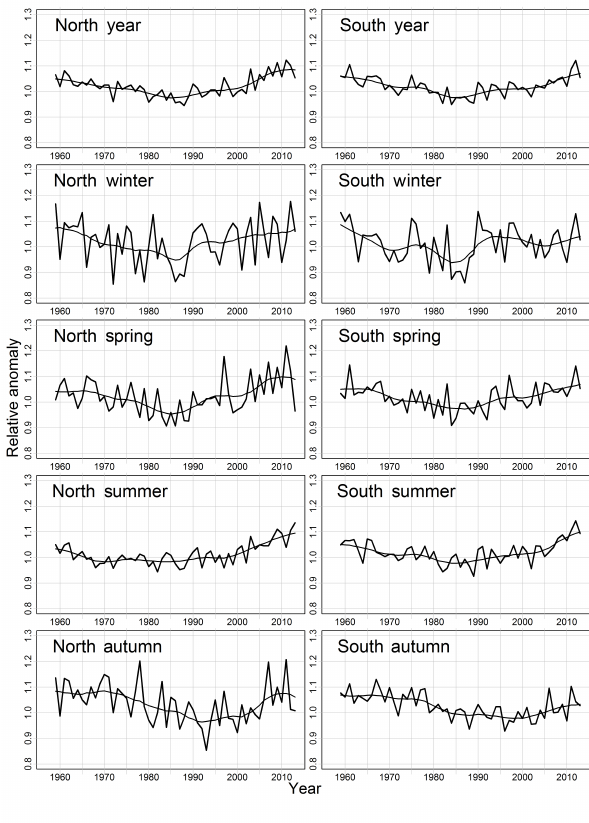
Figure 4. Average annual and seasonal northern (left column) and southern (right column) Italian SSR records obtained under all-sky conditions (bold lines), plotted together with an 11-year window, 3- year standard deviation Gaussian low-pass filter (thin lines). The se- ries are expressed as relative deviations from the 1976–2005 means.